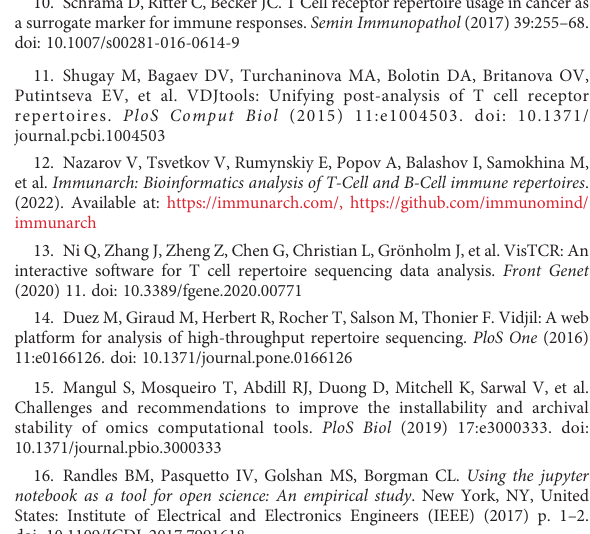
represented eachsample, y-axis represented different Vgenes. The shade of the color corresponded to the V gene frequency. (C) The V-J combinations with V and J gene frequencies in sample 3602BW were presented as a Sankey plot. SUPPLEMENTARY FIGURE 5 The diversity indices were shown in groups by hospitalization status. The patients that were not hospitalized were shown in blue while the patients that were hospitalized were shown in orange. (A) violin plot of the Shannon Wiener index (B) strip plot of normalized Shannon Wiener index (C) swarm plot of inverse Simpson index (D) box plot of Gini Simpson index (E) boxen plot of D50 index (F) point plot of Chao1 estimate (G) bar plot of Gini coef fi cient. SUPPLEMENTARY FIGURE 6 The overlap indices across samples. Heatmaps of each overlap index as shown above. The x-axis and the y-axis presented each sample. (A) Jaccard index (B) Overlap coef fi cient (C) Morisita-Horn index (D) Tversky index (E) Cosine similarity (F) Pearson correlation based on clonotype counts (G) Pearson correlation based on clonotype frequency (H) Relative overlap diversity (I) Geometric mean of relative overlap frequencies (J) С lonotype-wise sum of geometric mean frequencies (K) Jensen-Shannon divergence of variable gene usage distributions. SUPPLEMENTARY FIGURE 7 The number of highly presented motifs across samples grouped by hospitalization status. The x-axis presented motifs and the y-axis presented the count of the motifs. (A) amino acid motifs (k=6) that had numbersofcountsofnolessthan9,999andwerepresentedinmorethan 2 samples in hospitalization and non-hospitalization groups were shown in the strip plot (B) nucleotide motifs (k=6) that had numbers of counts of more than 150,000 and were presented in more than 2 samples in hospitalization and non-hospitalization group were shown in the strip